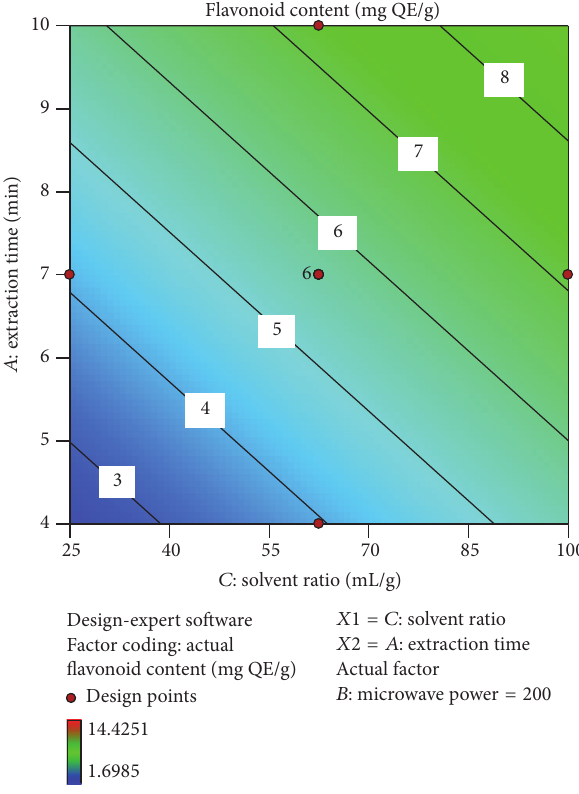
Figure 6: Response surface plot of the interaction between sol- vent/solid ratio ( 𝐶 ) and time ( 𝐴 ) on the total flavonoid content of roselle